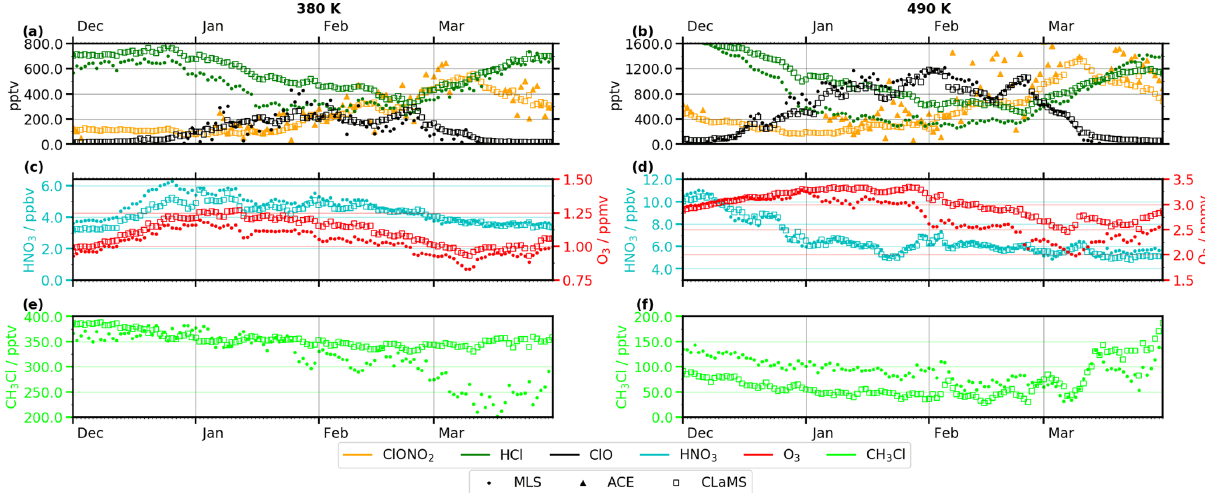
Figure 4. Time series of vortex-averaged trace gases from satellite measurements and CLaMS simulation at 380K (a, c, e) and 490K (b, d, f) . CLaMS data are shown as open squares, MLS as filled points, and ACE-FTS as triangles. The evolution of chlorine species (ClONO 2 : orange; HCl: green; ClO: black) is illustrated in the first row (a, b) , HNO 3 (cyan) and O 3 (red) in the second row (c, d) , and CH 3 Cl (light green) in the third row (e, f)